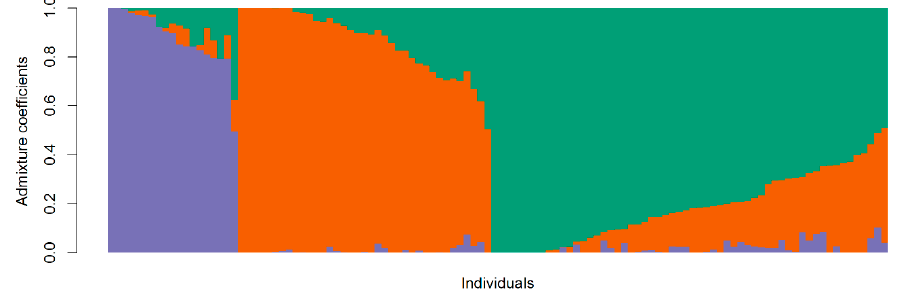
Figure 5. Model-based structure of the population of the 114 sorghum lines evaluated in this work. Cluster A (slightly desaturated blue color), Cluster B (vivid orange color), Cluster C (dark-cyan color).